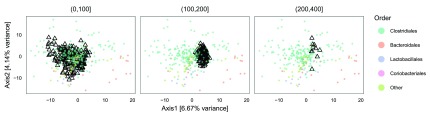
The biplot resulting from the PCA after the truncated-ranking transformation.